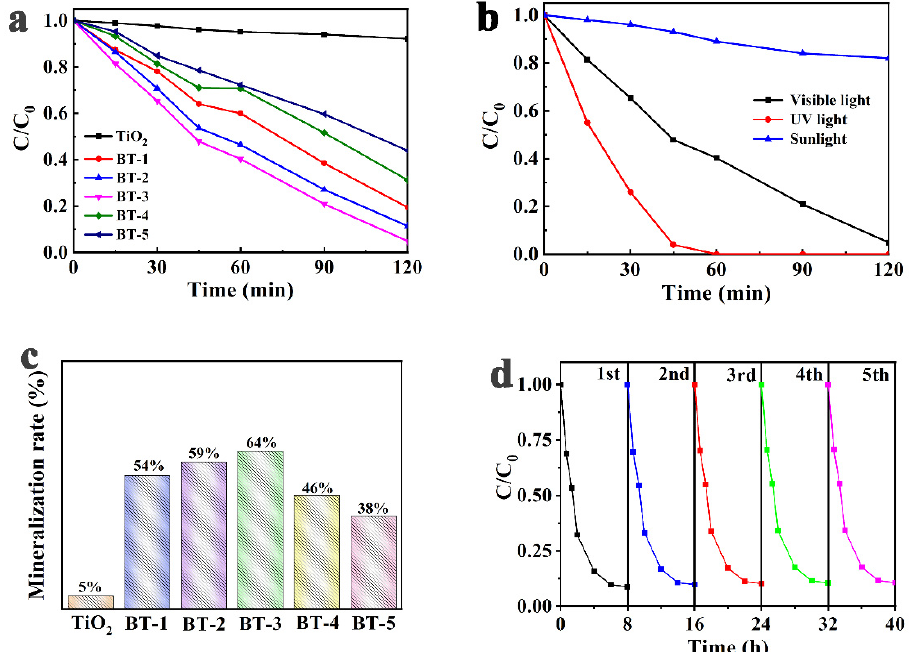
Figure 6. ( a ) PFC degradation of RhB of as-prepared photoanodes under visible light irradiation; ( b ) PFC degradation of RhB by BT-3 sample under visible light, UV light and sunlight irradiation; ( c ) TOC of RhB in the PFC using the as-prepared samples under visible light irradiation; ( d ) repeatability test of BT-3 photoanode for 5 times PFC process.